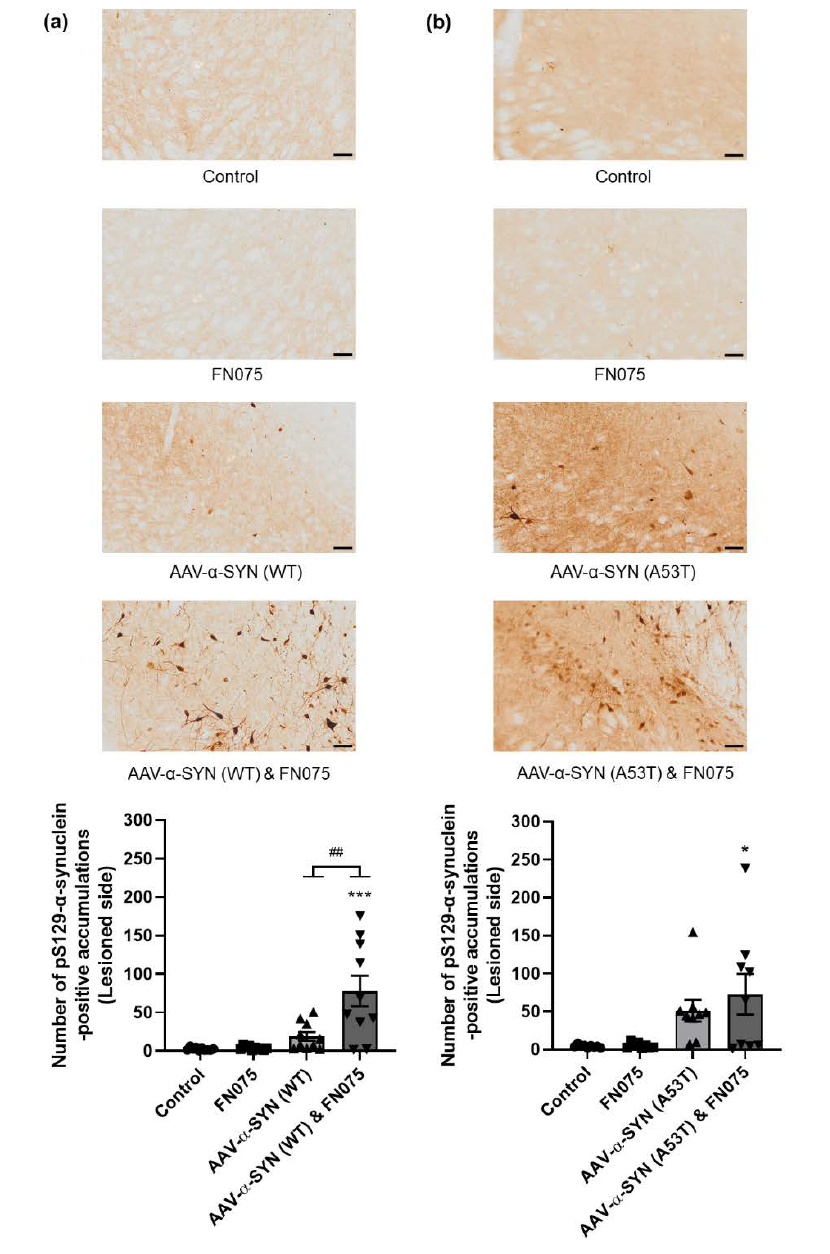
Figure 4. Immunohistological assessment of the impact of FN075 on the accumulation of phospho- rylated α -synuclein in the substantia nigra. FN075 in combination with ( a ) AAV- α -SYN (WT) or ( b ) AAV- α -SYN (A53T) induced a significant increase in the number of cells with pS129- α - synuclein accumulations in the substantia nigra. Scale bars represent 50 µ m. Data are represented as mean ± SEM with n = 8–10 animals per group. * p < 0.05, *** p < 0.001 vs. Control; ## p < 0.01 vs. corresponding AAV- α -synuclein group by one-way ANOVA with post hoc